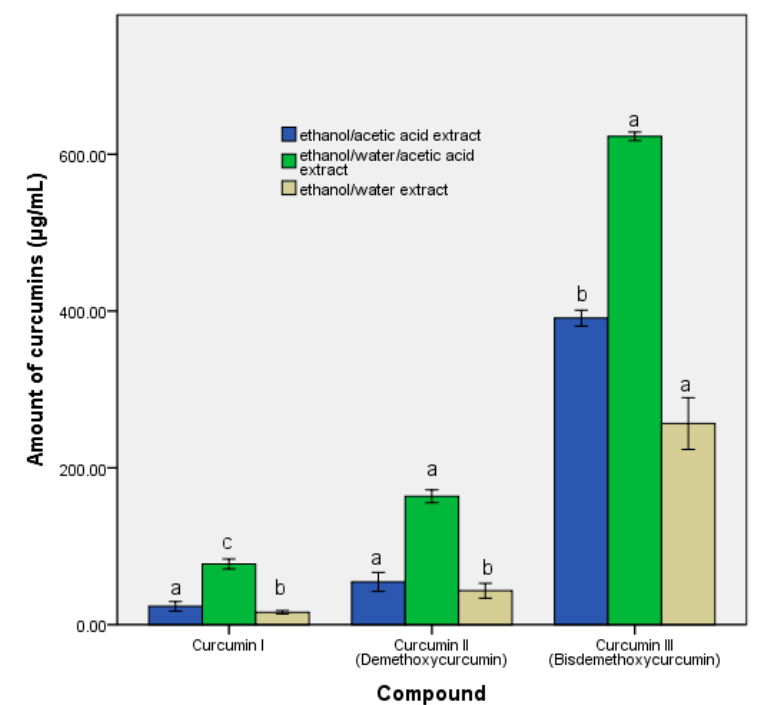
Figure 3. The total amount of curcumins in the three extracts. Within each group of samples, different letters mean significant statistical differences ((a = p ≤ 0.05; b = p ≤ 0.01; c = p ≤ 0.001), n = 3).